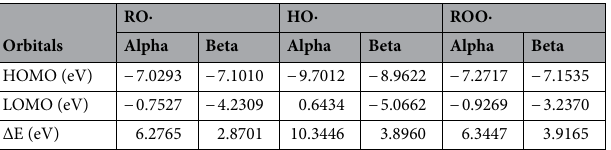
Table 7. Frontier orbital energy levels (HOMO, LUMO) and energy gap (eV) of oxygen-containing radicals.